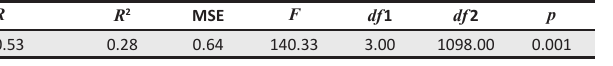
TABLE 3: Interactive effect between workplace bullying and emotional intelligence in predicting flourishing (model summary).